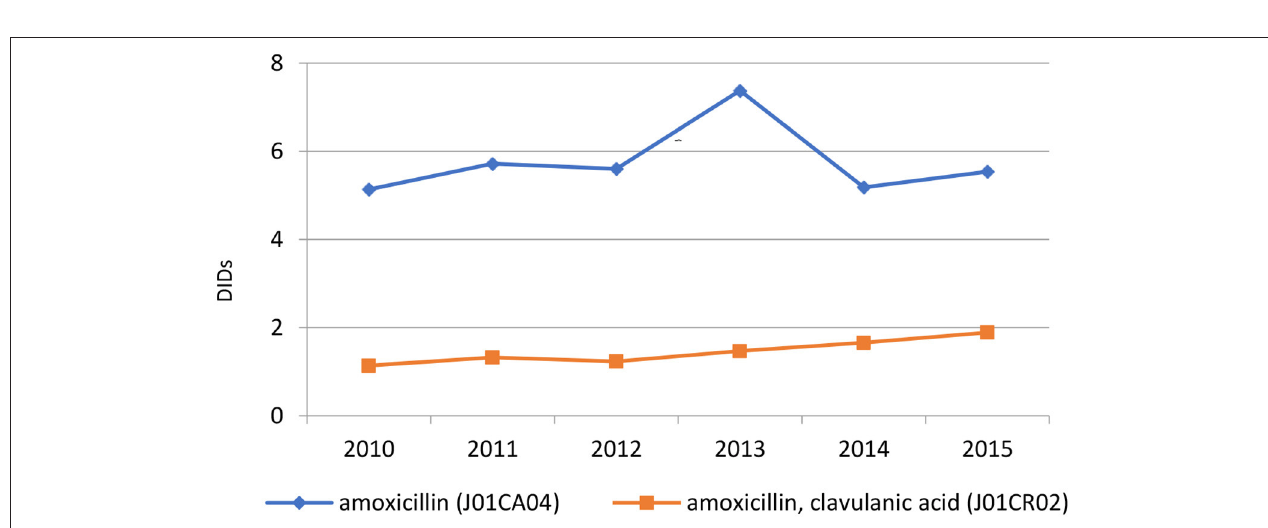
FIGURE 2 | Amoxicillin vs. co-amoxiclav utilization expressed in DIDs from 2010 to 2015.